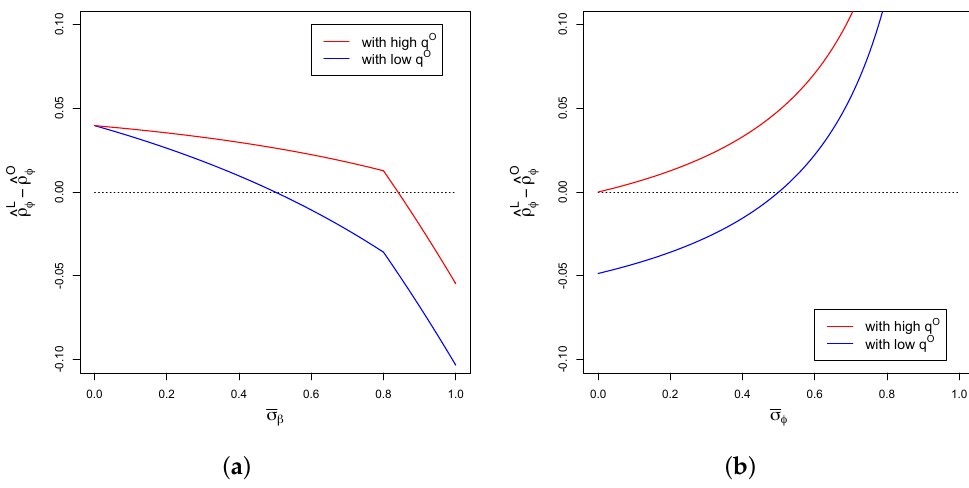
Figure 1. Complementary effect of media quality and censorship. ( a ) Case 1. ( b ) Case